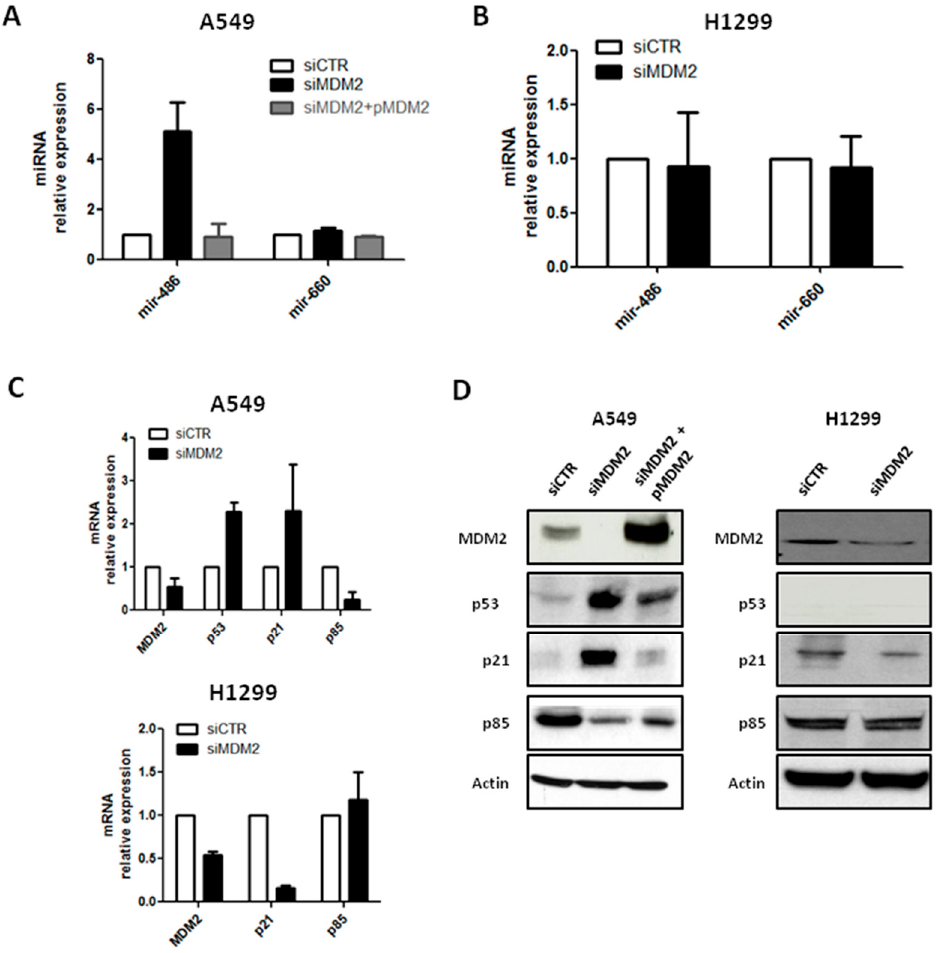
Figure 3. MDM2 down-modulation increased mir-486-5p levels and activity. ( A,B ) mir-486-5p and mir-660-5p expression after MDM2 silencing in A549 ( A ) and H1299 ( B ) lung cancer cells; ( C ) bar graphs showing transcript modulation in A549 (upper graph) and H1299 (lower graph) cells after down-modulation of MDM2; ( D ) representative Western blot bands of the MDM2/p53 axis and their downstream genes in A549 (left) and H1299 (right). All data are expressed as mean ± SEM ( n = 2 for each cell).